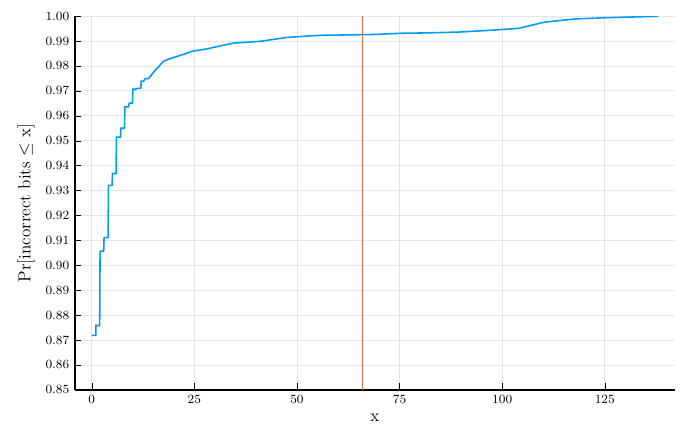
Figure 4: Empirical cumulative distribution function of the number of incorrect bits during the attacks. Approx. 87 % succeeded immediately. For those that failed additional post-processing steps could further improve the success probability. The vertical line indicates the weight of the secret key y . Less than 1 % of cases the attack terminated with more incorrect bits than bits are set in the secret